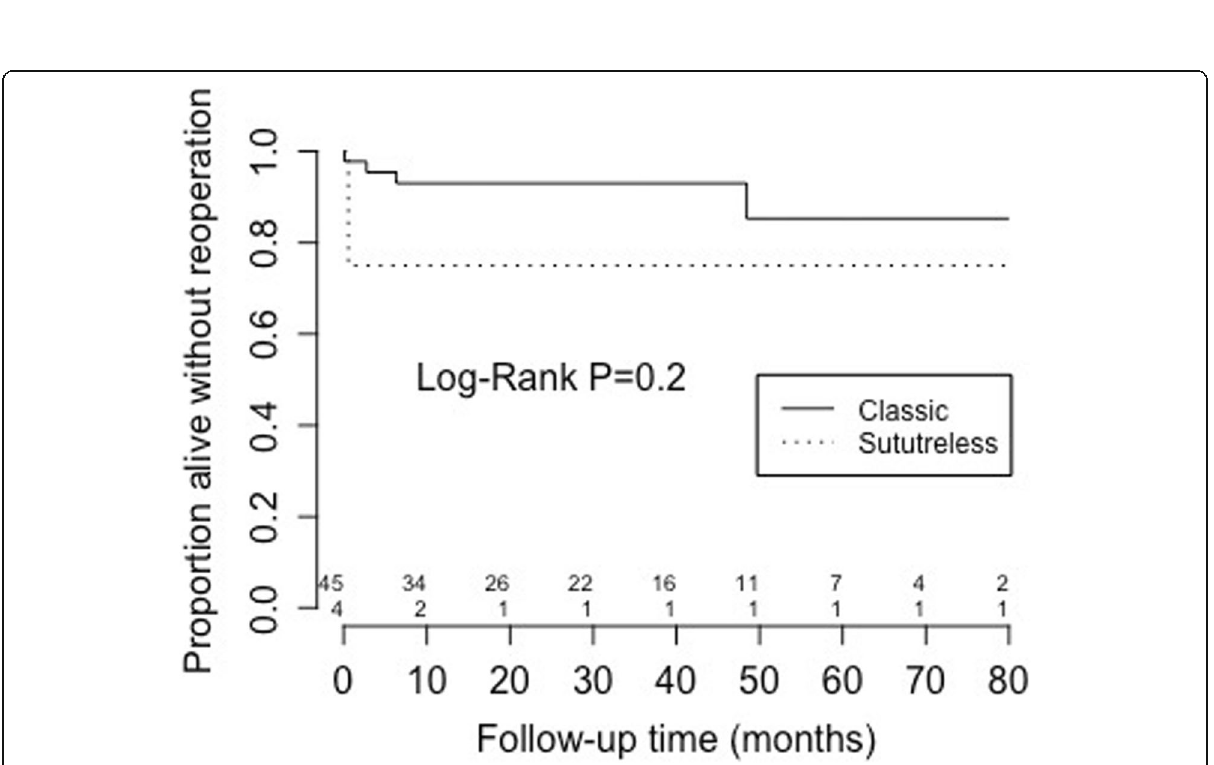
Fig. 3 Kaplan-Meier freedom from death or reoperation in classic and sutureless repair